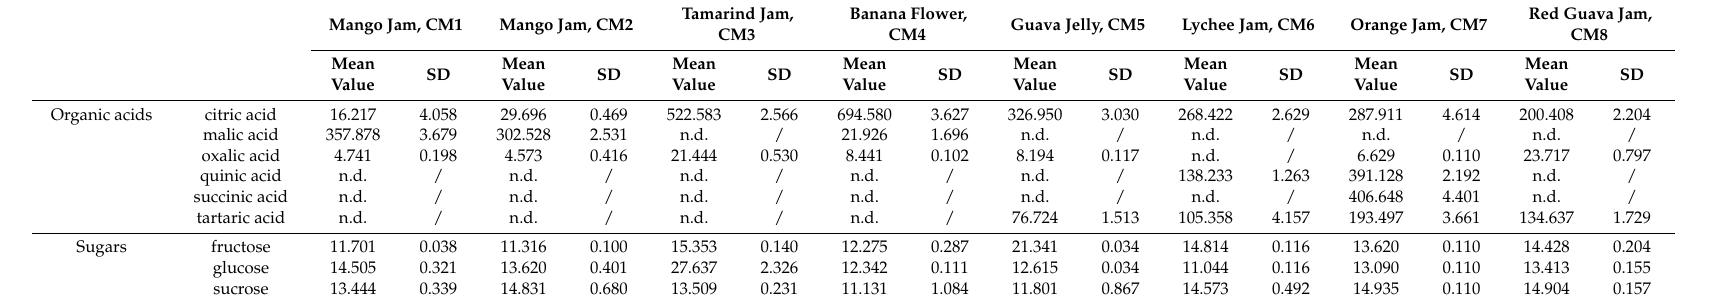
Table 4. Phytochemical fingerprint of nutritional substances in analysed jams and